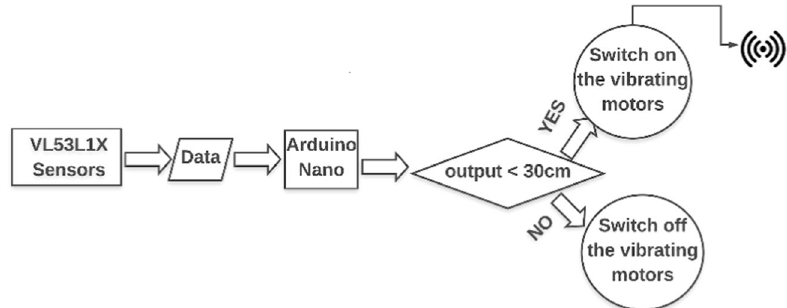
Fig. 3 Working flow of the Blind’s apron for the object detection